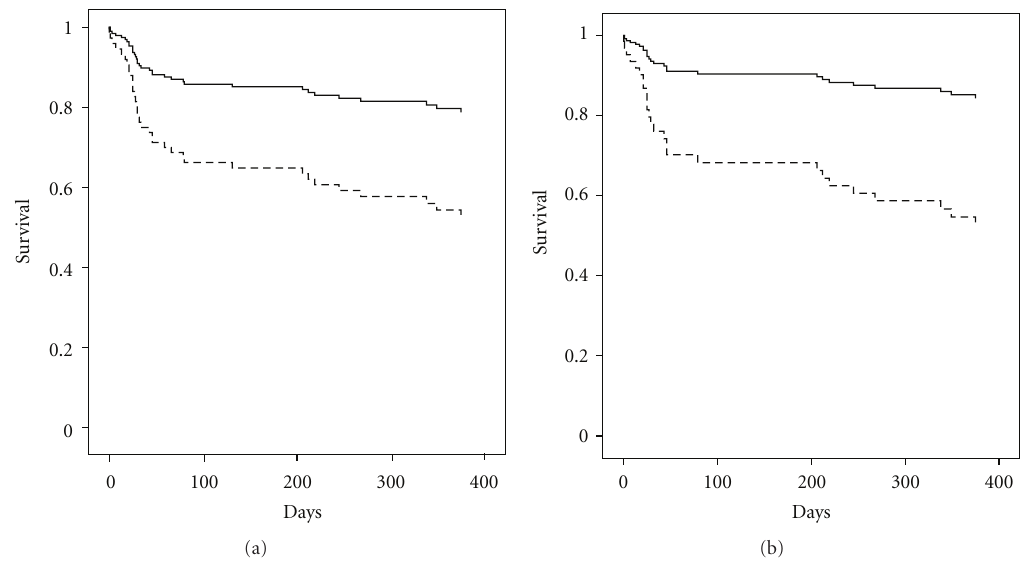
Figure 1: Cumulative survival in pts. with (dotted lines) and without AKI (solid lines). (a) Crude cumulative survival (days) (HRR 2.7, CI 1.34–5.41, P < 0 . 01). (b) Adjusted cumulative survival (days) (HRR 3.8, CI 1.37–10.37, P = 0 . 01); adjusted for age, diabetes, PAD, hypertension, previous myocardial infarction and CABG, left ventricular function, amount of contrast dye, baseline creatinine, and hemoglobin.